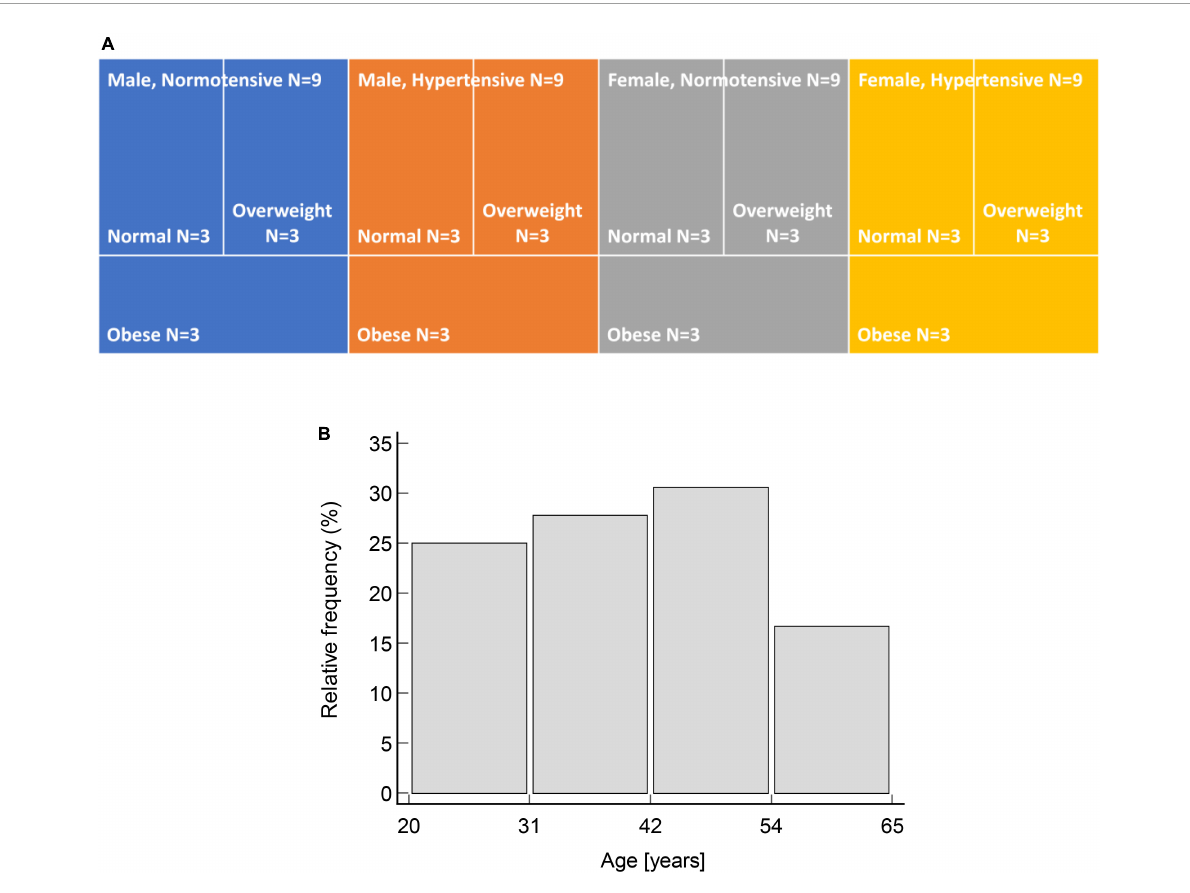
FIGURE1 Uniform distribution of participants by: (A) Sex, hypertensive status and BMI categories; and (B) age ( χ 2 = 1.5, p =